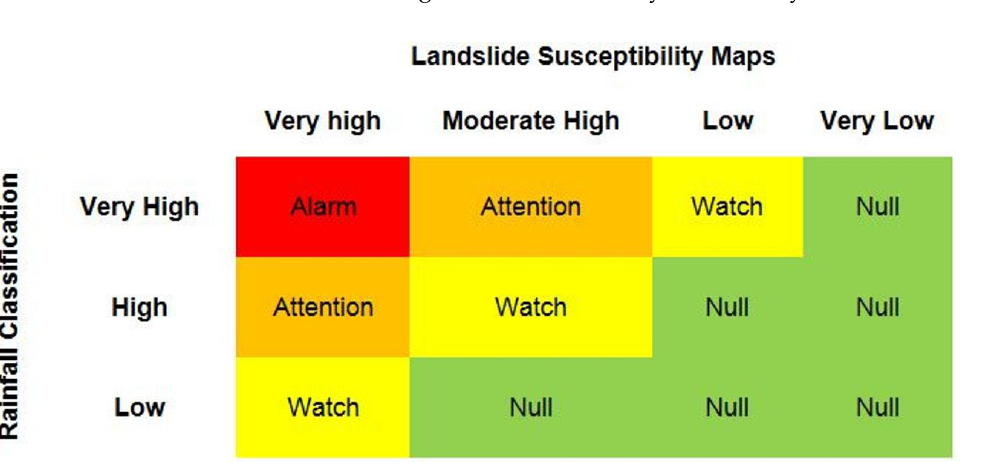
Figure 9. Definition of the warning system.